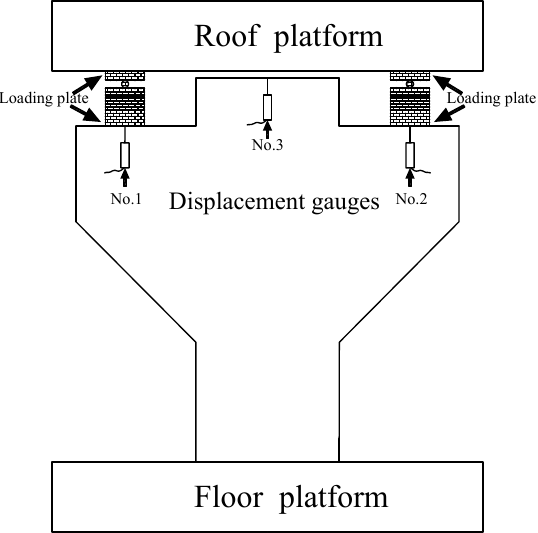
Figure 3. Displacement meter layout.